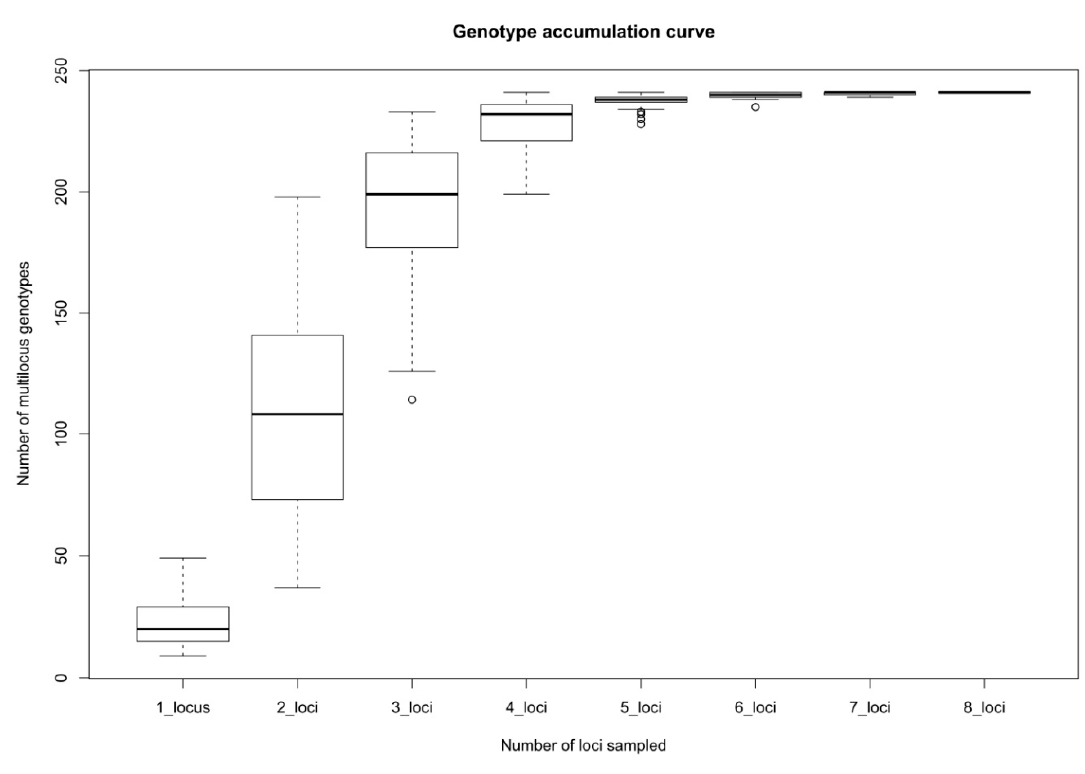
Figure 2. A genotype accumulation curve for 687 sampled individuals of S. brachyodon . Box plots were constructed from the number of observed multilocus genotypes (up to 241, the number of unique MLGs in the data set: y axis) and the number of assayed SSR loci ( x axis) To assign multilocus genotypes to multilocus lineages (MLLs), a histogram derived from the